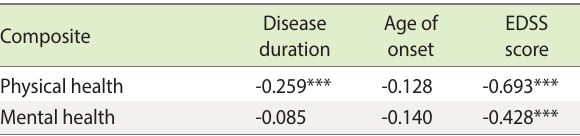
Table 3. Correlations between disease duration, age of onset,